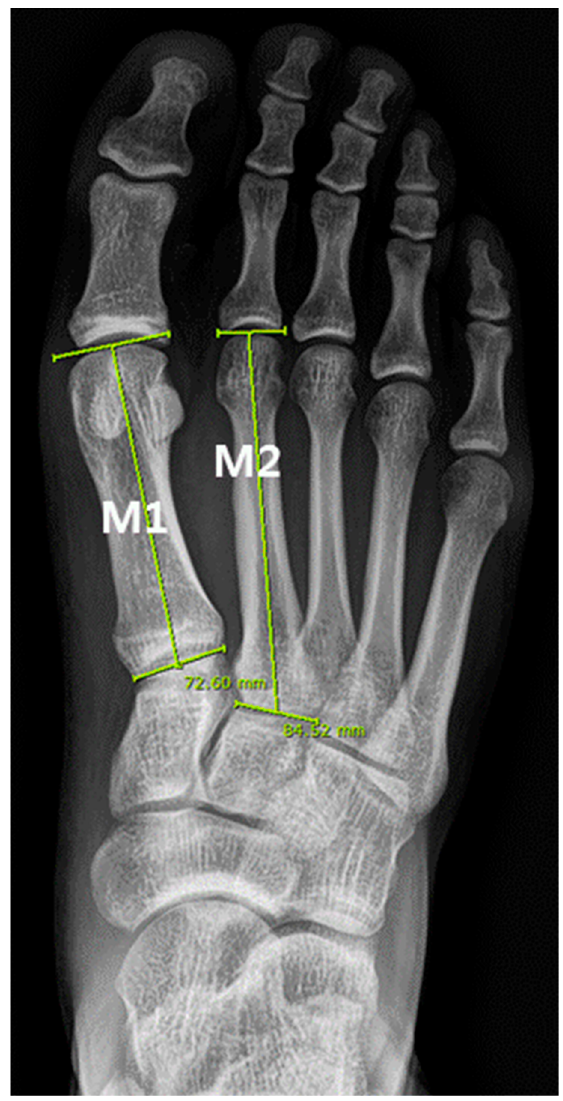
Figure 2. Digital measurements (green lines) were used to calculate metatarsal length: 1st and (M1) and 2nd (M2) metatarsal bone.